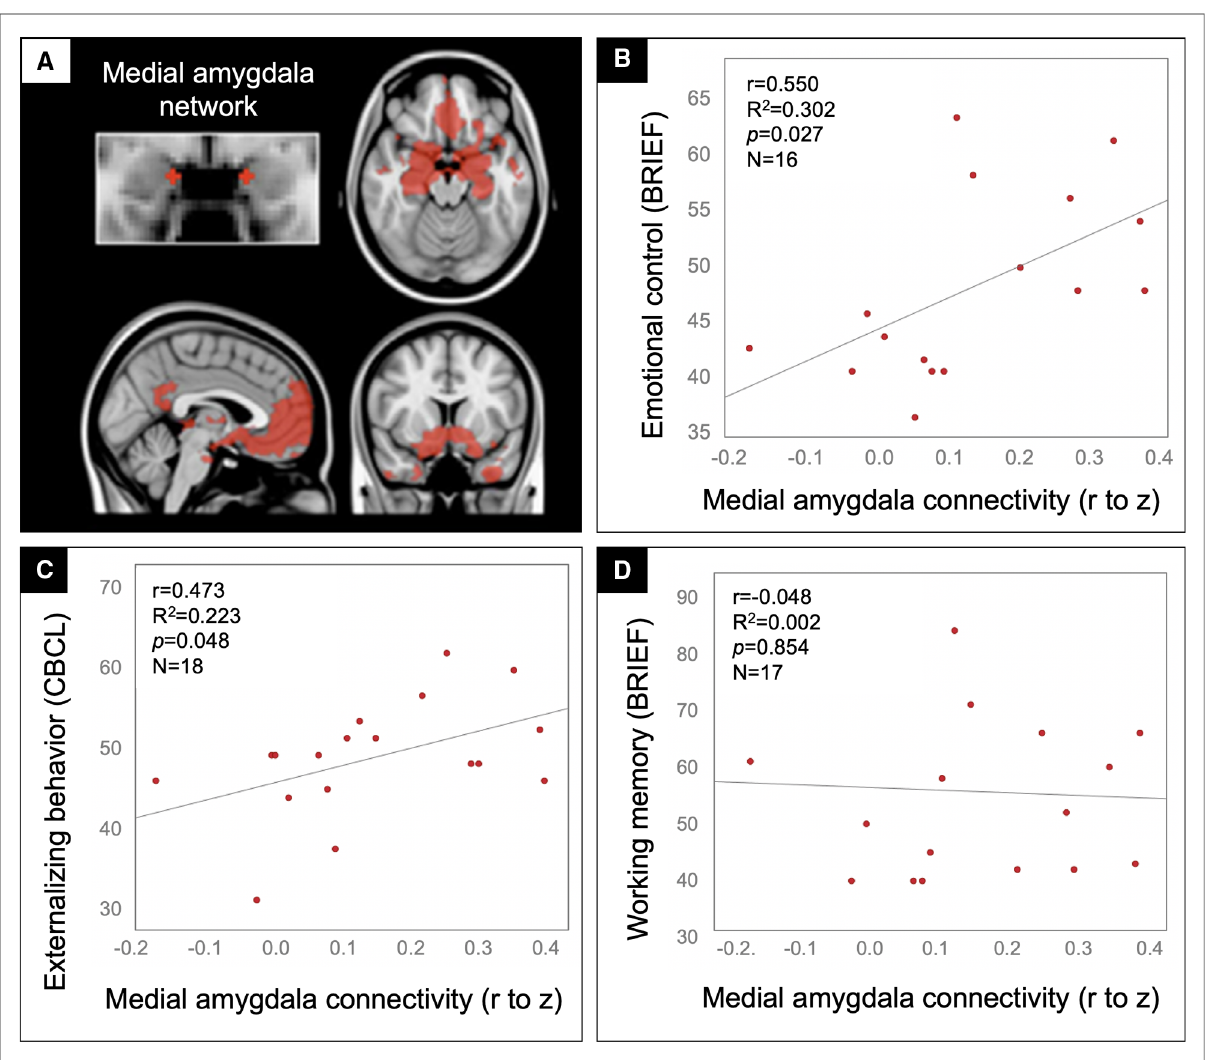
FIGURE 2 Medial amygdala hyperconnectivity predicted behavioral dysregulation but not working memory problems for patients in the TBI group. Scatter plots showing the correlation between medial amygdala ( A ) rFC values (x-axis) and the BRIEF Emotional control ( B ), CBCL Externalizing behavior ( C ), and BRIEF Working memory ( D ) scale ratings (y-axis) with statistics for the Pearson correlation